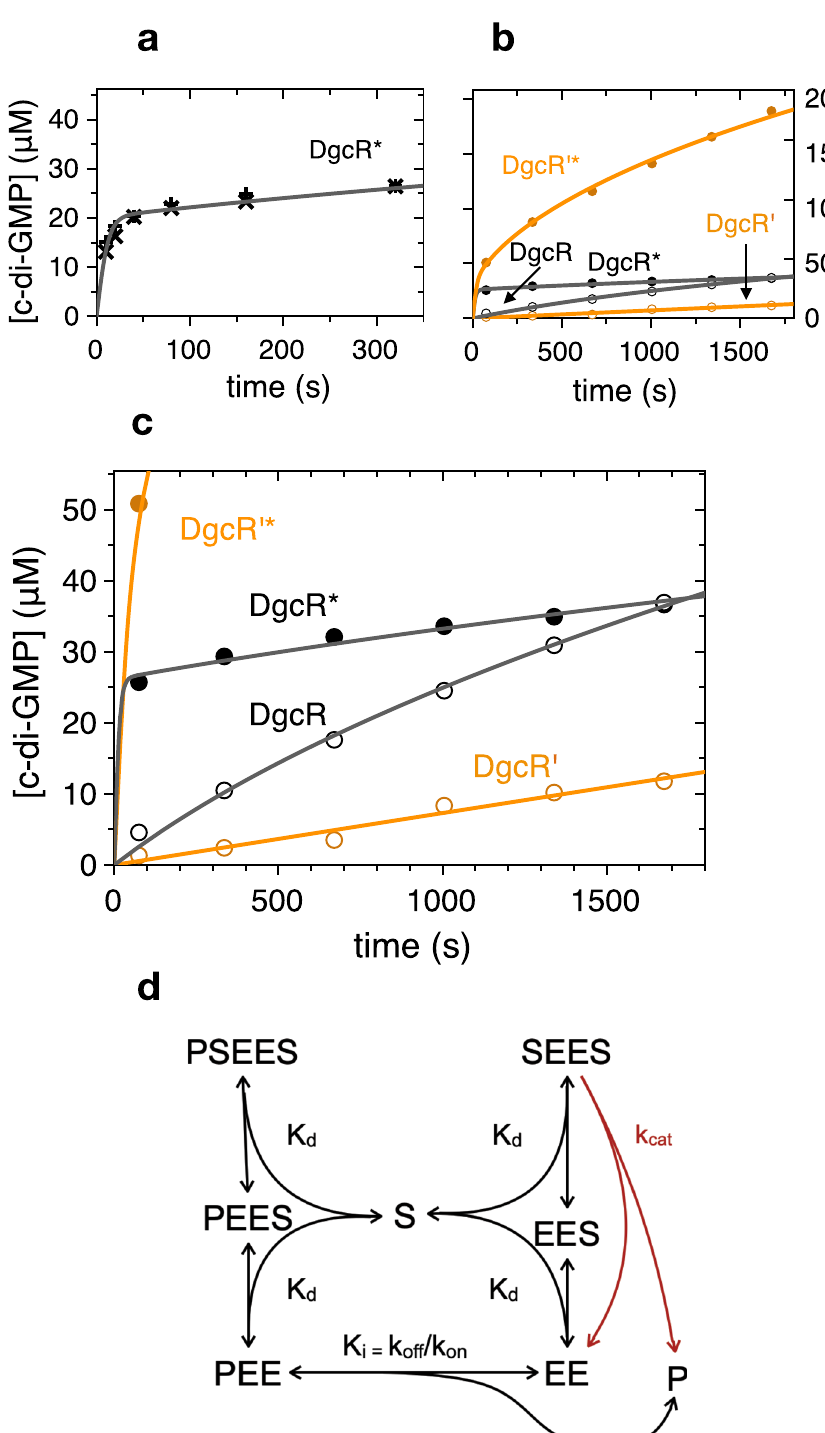
Fig. 9 Enzyme kinetics of DgcR. a – c Enzymatic progress curves of wild-type DgcR and inhibition relieved mutant DgcR ’ in the native and in the activated (indicated by asterisk) state. Experiments were performed with 5 μ M enzyme and 500 μ M GTP substrate concentrations. Symbols denote experimental values, continuous lines represent fi t of the kinetic model shown in panel d to the data with parameters listed in Supplementary Table 2. a Progress curve of c-di-GMP production catalysed by DgcR* as measured by conventional IEC. b Progress curves as measured by oIEC catalysed with the indicated DgcR variants/states. c Zoom- in of b . d Kinetic model of diguanylate cyclase activity controlled by non-competitive product binding. Substrate (S) binding to the dimeric enzyme (EE) is modelled with the equilibrium dissociation constant K d and assumed to be unaffected by the presence of S in the second binding site or of product (P) in the allosteric site. Product binding is modelled kinetically with rate constants k on and k off . Note that the model considers simply one instead of four product binding sites on the enzyme. Only the Michaelis – Menten complex with two bound substrate molecules and no bound product (SEES) is competent to catalyse the S + S → P condensation reaction (with turn-over number k cat ). Source data are provided as a Source Data fi le.